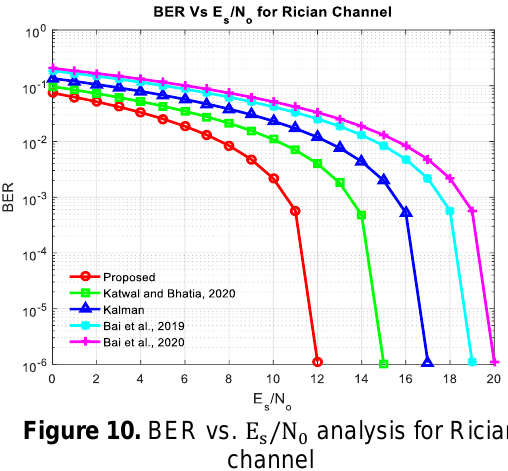
Figure 10. BER vs. E analysis for Rician /N s 0 channel BER evaluation against energy per symbol to noise spectral density using the Rician